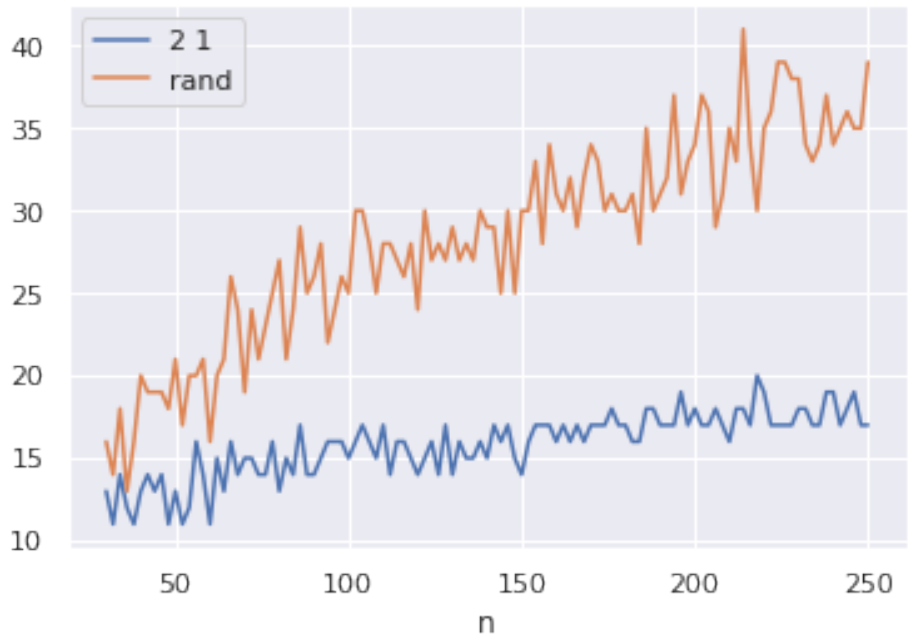
Figure 9. The cardinality of (1,2)-dominating sets returned by the Minimal_12_Set and random algorithms in random